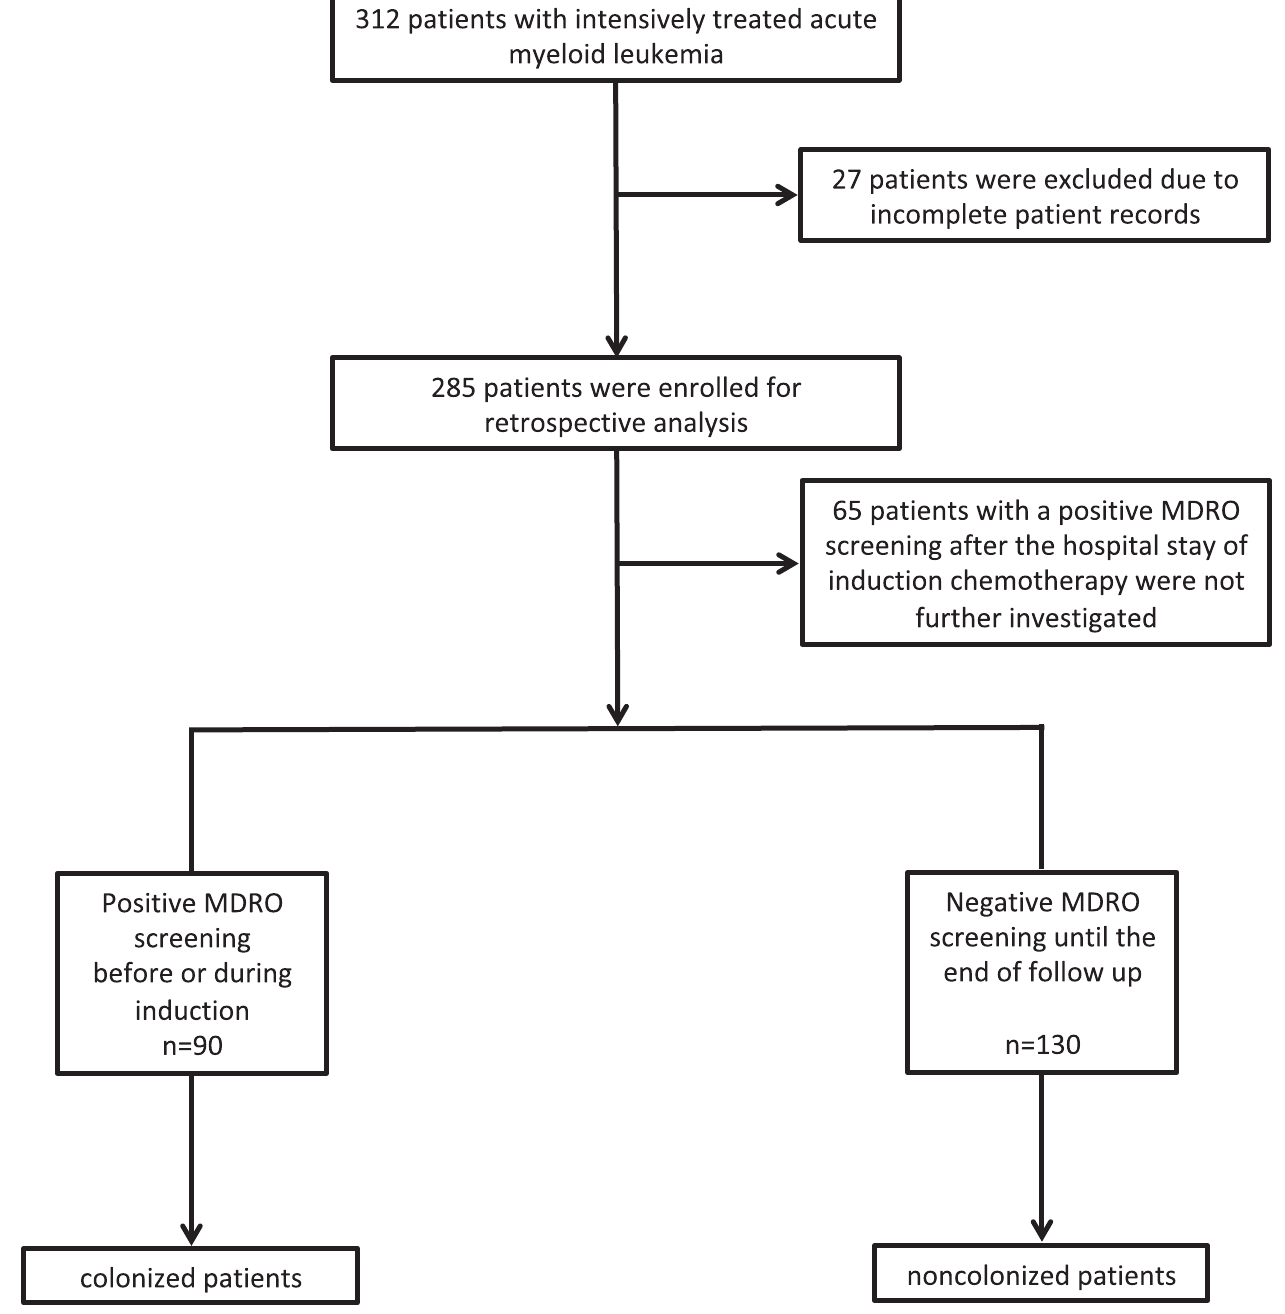
Fig 1. Flow sheet for screening, enrollment and